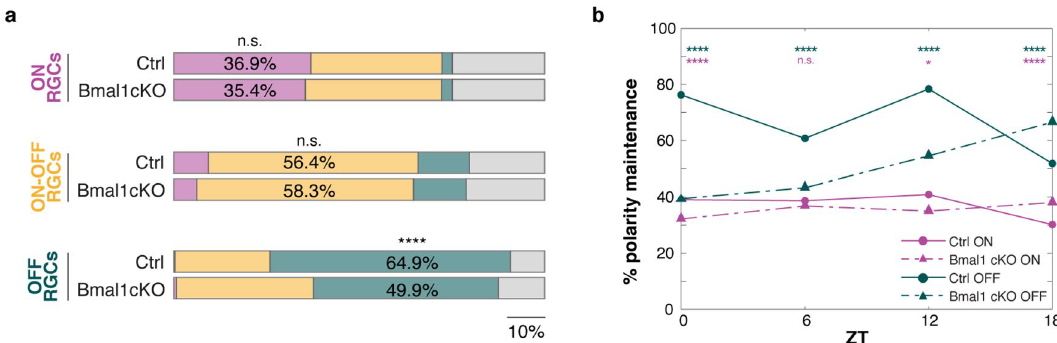
Figure 7. Mean light luminance polarity shift for OFF preferential RGCs is altered upon glial BMAL1 deletion. (a) Polarity maintenance was calculated as the percentage of cells within the ON, ON–OFF, and OFF subtypes that did not change their polarity preference at different ambient illumination in Ctrl and Bmal1 cKO (Fisher’s exact test to assess the difference between groups). (b) The analysis in ( a ) has been performed only for ON and OFF RGCs at different ZTs collected from 37 datasets. Significance asterisks are displayed for Ctrl and Bmal1 cKO comparison. *P < 0.05; ****P < 0.0001; ns = not